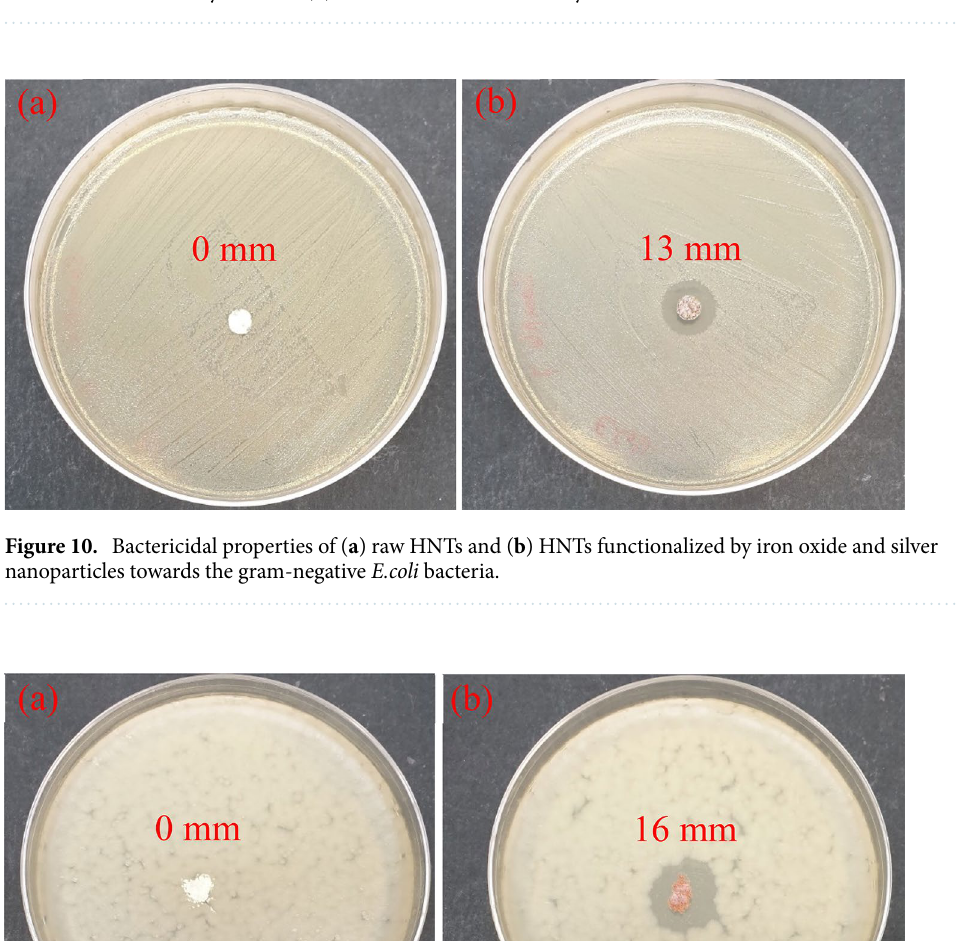
Figure 9. In ( a ) the root mean square displacement (RMSD) respect the starting structure, as a function of time for all the atom in the system and ( b ) for the Si and Al atoms only.